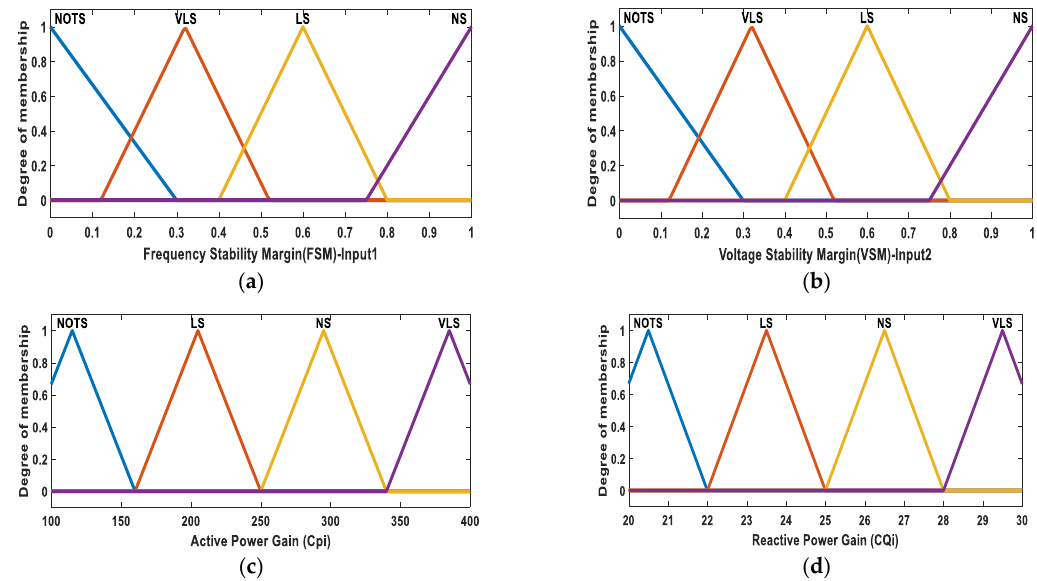
Figure 7. Membership functions for ( a ) input1, frequency stability region; ( b ) input2, voltage stability region; ( c ) output1, active power gain, 𝐷 𝑃𝑖 and ( d ) output2, reactive power gain, 𝐷 𝑄𝑖 .